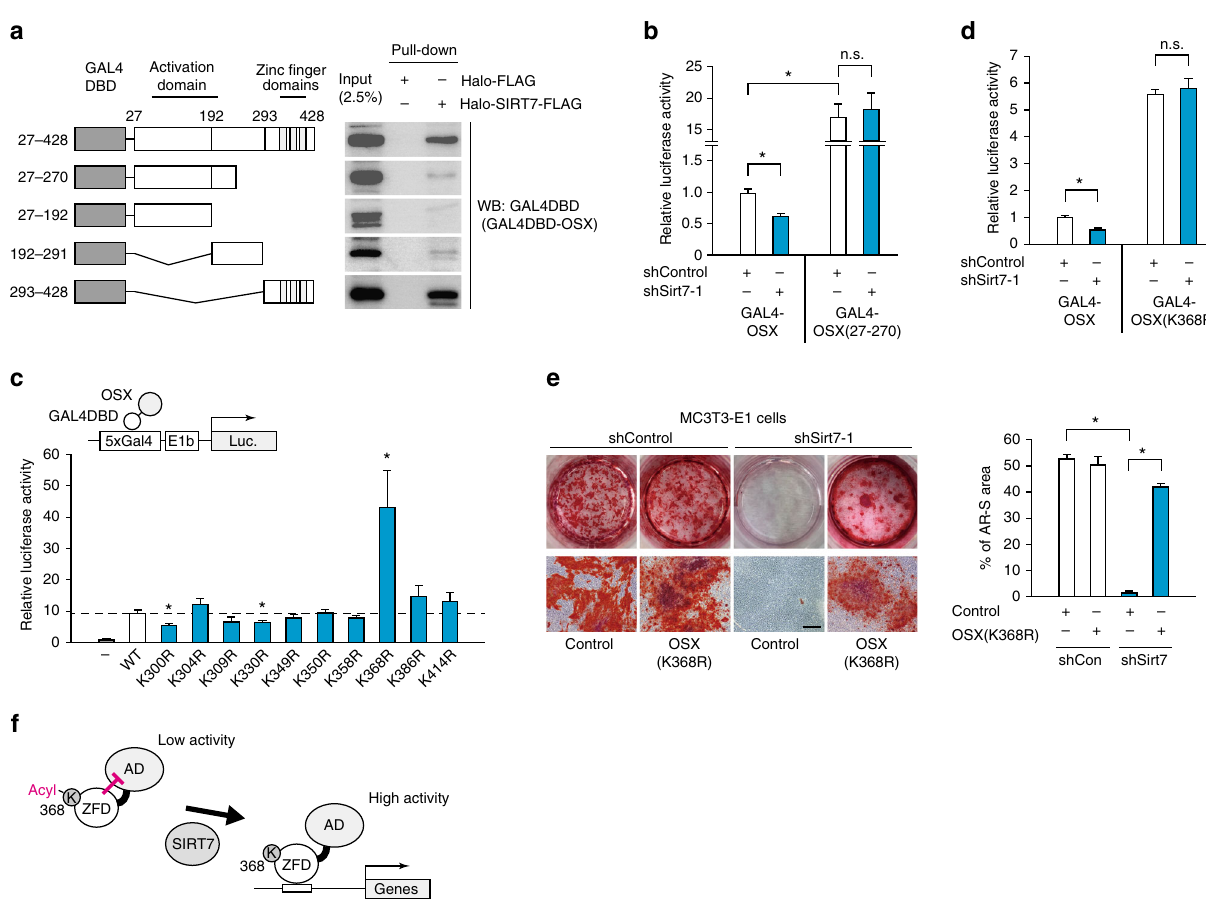
Fig. 6 SIRT7 increases transactivation activity of OSX by deacylation of lysine 368. a Mapping the site of the interaction between OSX and SIRT7. Halo- SIRT7-FLAG pull-down assay with lysates of HEK293T cells expressing the indicated OSX deletion mutants fused with GAL4DBD. b Effect of Sirt7 de fi ciency on N-terminal transactivation activity of OSX in MC3T3-E1 cells. After the indicated shRNA was introduced, cells were transfected with the GAL4DBD-OSX or GAL4DBD-OSX (27 – 270) expression plasmid, as well as the 5× GAL4-luciferase reporter plasmid. Luciferase activity was determined at 24 h after transfection ( n = 6 each). c Transactivation activity of OSX KR mutants in MC3T3-E1 cells. Cells were transfected with the GAL4DBD-OSX expression plasmid (WT) or the indicated GAL4DBD-OSX expression plasmid (KR mutants), as well as the 5× GAL4-luciferase reporter plasmid. Luciferase activity was determined after 24 h ( n = 6 each). d Effect of Sirt7 de fi ciency on transactivation activity of OSX (K368R) mutants in MC3T3-E1 cells. After the indicated shRNA expression vectors were introduced, cells were transfected with the GAL4DBD-OSX or GAL4DBD-OSX (K368R) expression plasmid, as well as the 5× GAL4-luciferase reporter plasmid. Luciferase activity was determined after 24 h ( n = 6 each). e Effect of OSX (K368R) overexpression in Sirt7 knockdown MC3T3-E1 cells. The indicated shRNA was introduced into MC3T3-E1 cells, followed by transfection with each OSX (K368R) expression plasmid or empty plasmid. Then cells were cultured for 30 days in differentiation medium. Representative Alizarin Red S-stained images (left) and Alizarin Red S staining area ratio (right). f Proposed model for regulation of OSX transactivation activity by SIRT7 through deacylation of lysine 368. See the Discussion section for details. WB western blotting. Data are shown as the mean ± SEM. Statistical signi fi cance was determined